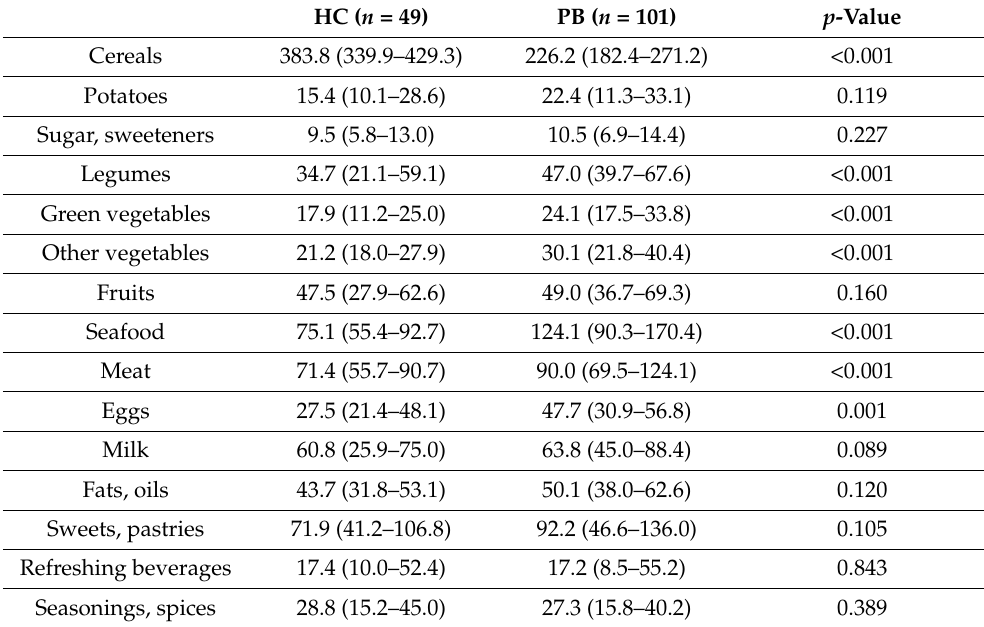
Table 2. Food group intakes in the two dietary patterns of the Cohort A classified by cluster